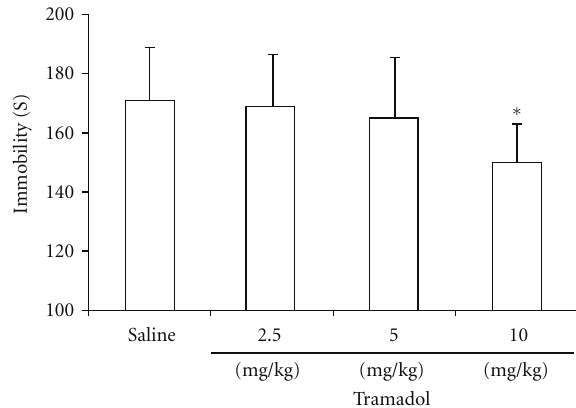
Figure 1: Immobility time of rats ( n = 10) during the FST after intraperitoneal injection of tramadol at di ff erent doses. Tramadol administered at the dose of 10 mg/kg significantly decreased the immobility time as compared to saline ( ∗ P < 0 . 05), while tramadol administered at the doses of 2.5 and 5 mg/kg both did not a ff ect the immobility time ( P > 0 . 05).